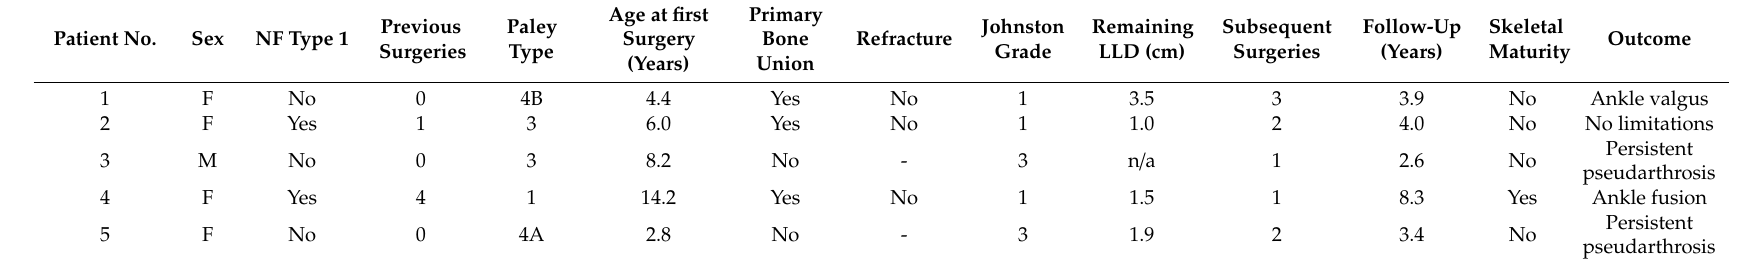
Table 3. Results Group C: Excision of the pseudarthrosis, acute compression, and intramedullary nailing. Patient